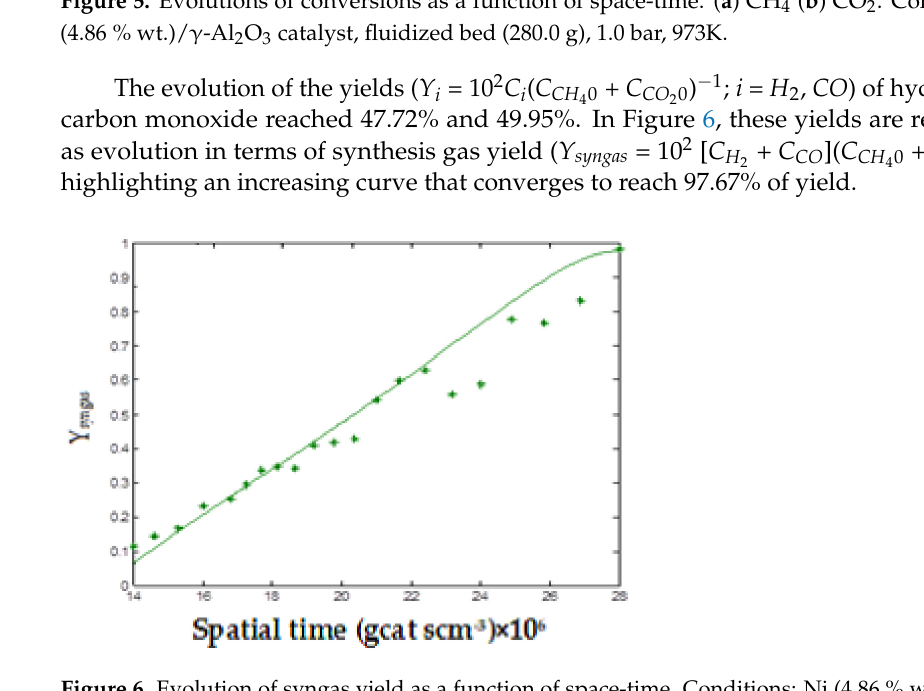
Figure 6. Evolution of syngas yield as a function of space-time. Conditions: Ni (4.86 % wt.)/ γ -Al 2 O 3 catalyst, fluidized bed (280.0 g), 1.0 bar, 973K.